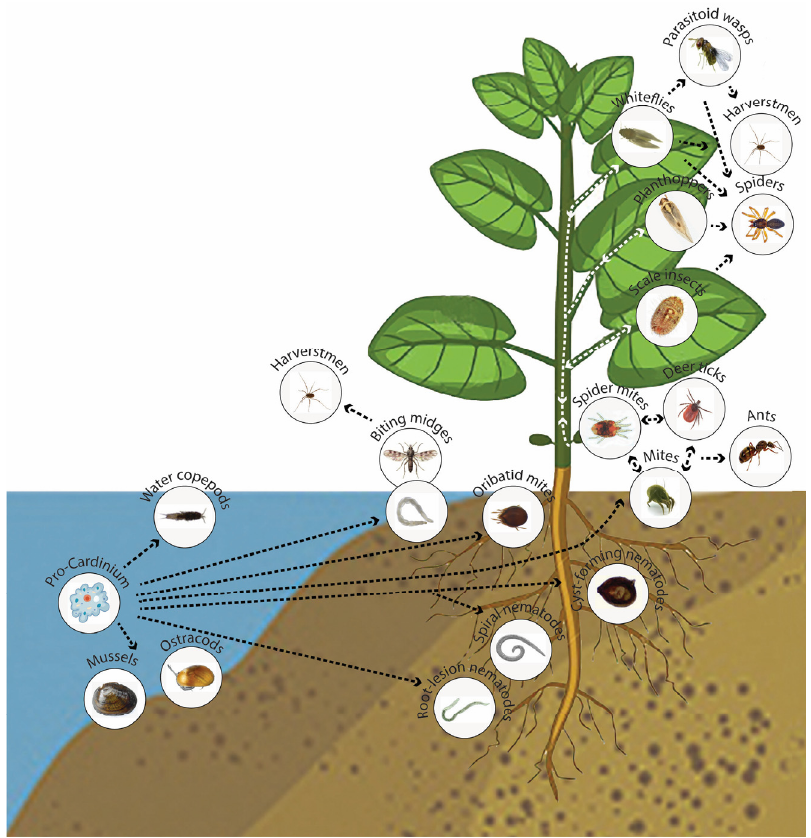
Figure 4. Schema of putative evolutionary relationships and horizontal transmissions of bacterial endosymbionts of the Cardinium clade within invertebrates. endosymbionts of the Cardinium clade within